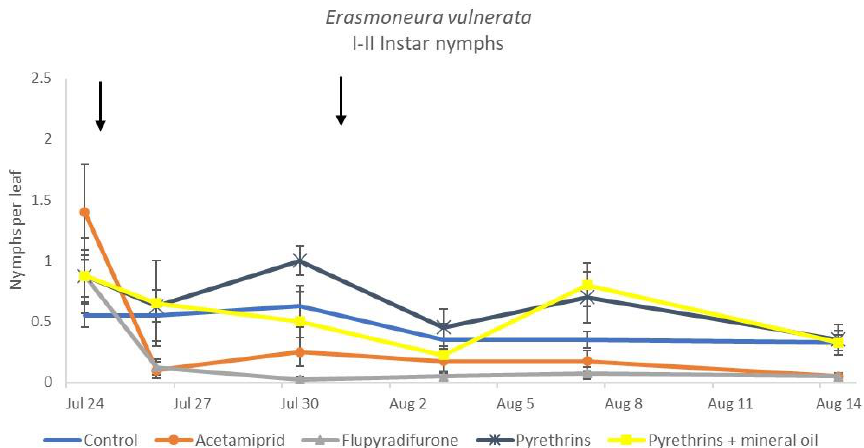
Figure 14. Dynamics of Erasmoneura vulnerata early (I-II instar) nymphs (mean ± std. err.) in the 2019 trial. Insecticides were applied one (first arrow) or two times (second arrow, see Materials and Methods section) .